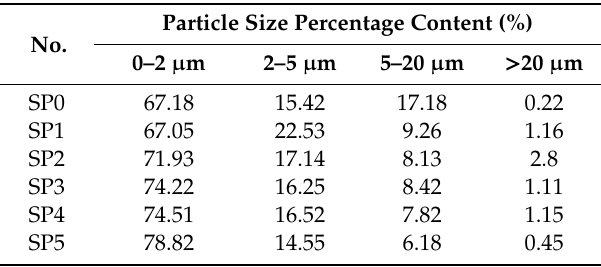
Table 11. Particle size percentage content.